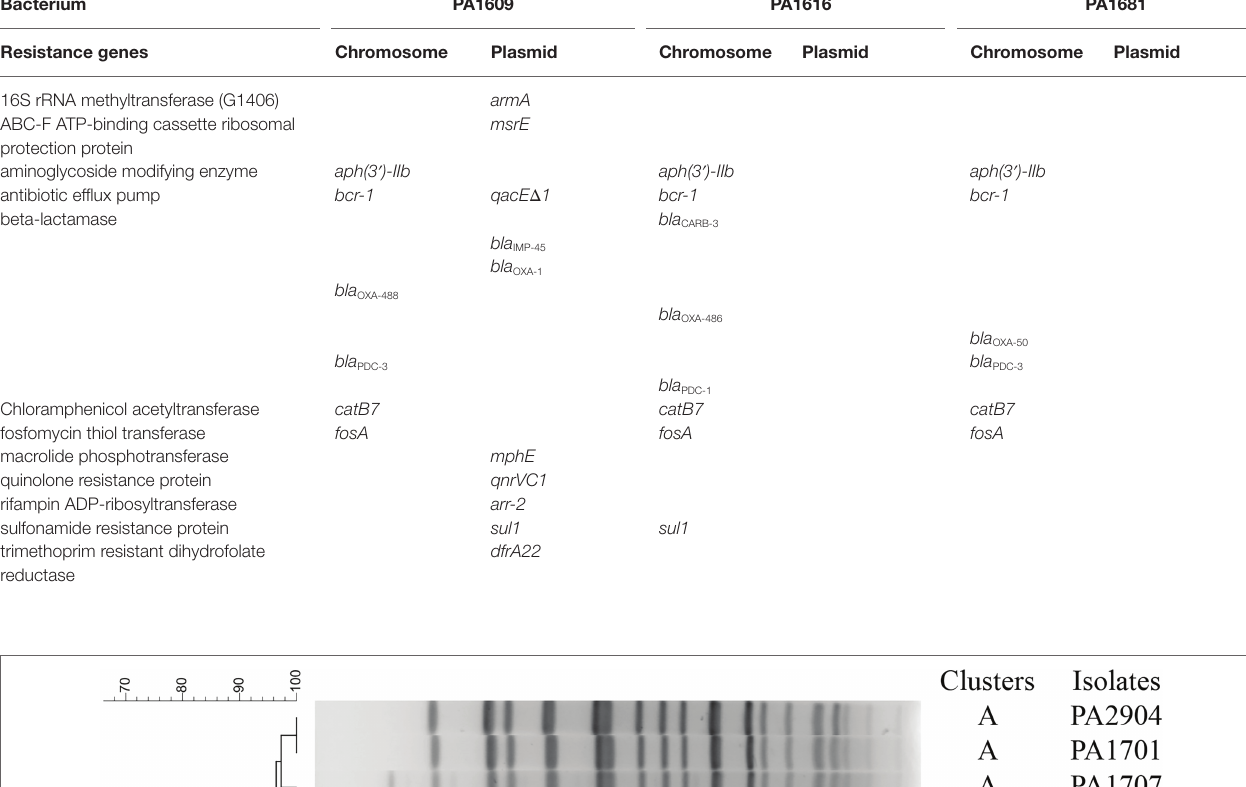
TABLE 4 | Resistance genes and their locations of the sequenced isolates. Bacterium